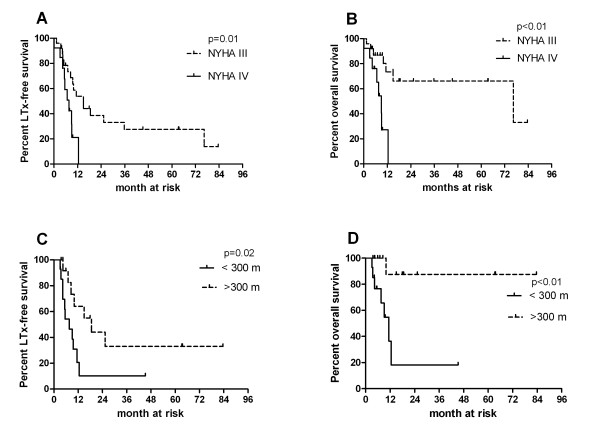
Kaplan-Meier curves demonstrating the impact of functional class (A and B) and 6MWD (C and D) 3 months after introduction of intravenous iloprost on the LuTx-free and overall survival from the time point iloprost-start. LuTx-free survival: Hazard ratio NYHA IV vs. III 3.87; 95% CI 1.38-10.84; Hazard ratio 6MWD < 300 m vs. > 300 m 3.14, 95% CI 1.17-8.45. Overall survival: Hazard ratio of NYHA IV vs. NYHA III: 8.39, 95% CI 2.28-30.83; Hazard ratio of 6MWT < 300 m vs. > 300 m: 8.76, 95% CI 2.05-37.5. |: censored patients.